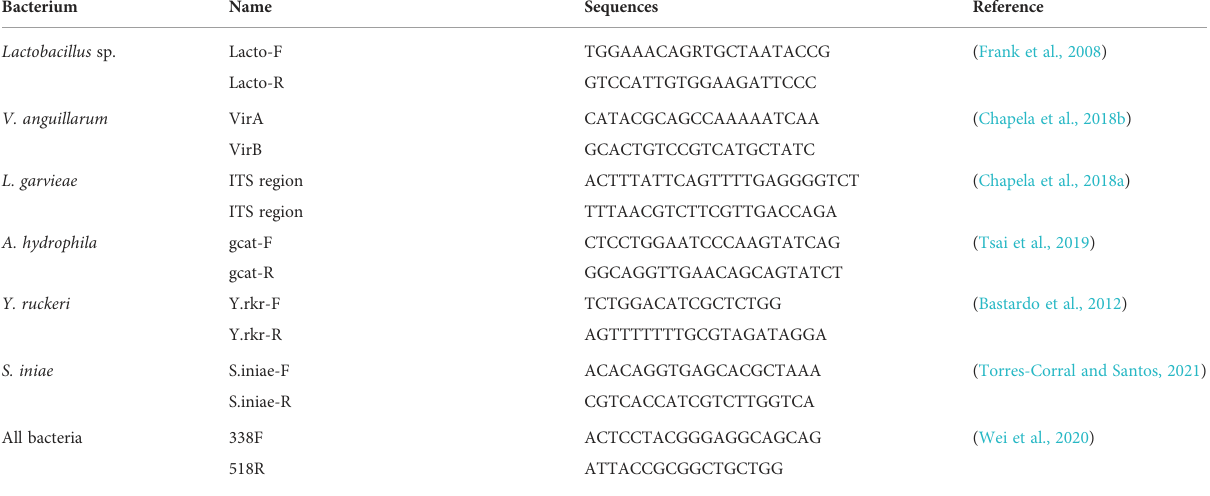
TABLE 3 Primer sequences used for detecting different bacteria in the fi sh intestine. Bacterium